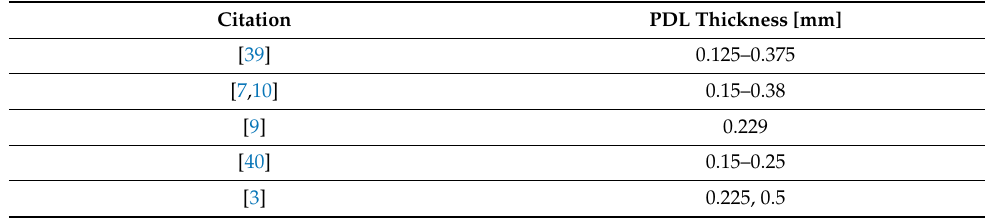
Table 1. Acceptable PDL thickness in